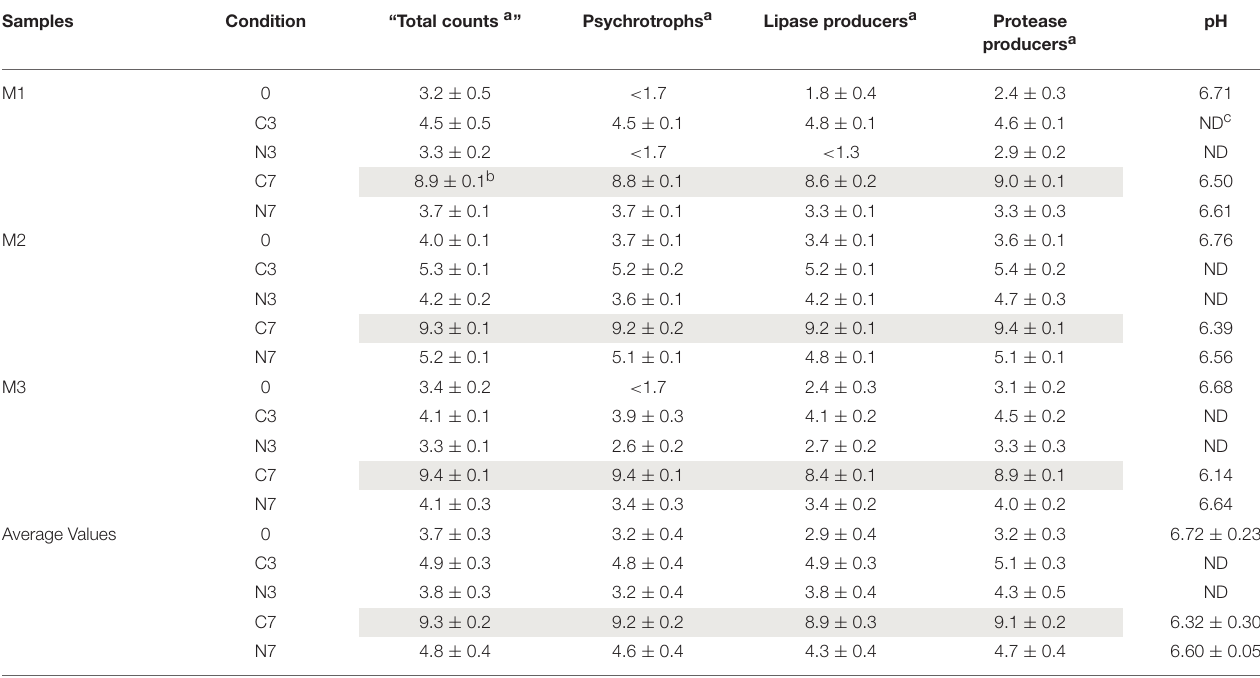
TABLE 1 | Bacterial counts (expressed in log cfu/mL) and pH values recorded for the raw- milk samples (M1–M3), at initial stage (0) and after 3 and 7 days under cold-storage (C3, C7), and under N 2 -flushing combined to cold-storage (N3, N7). Samples